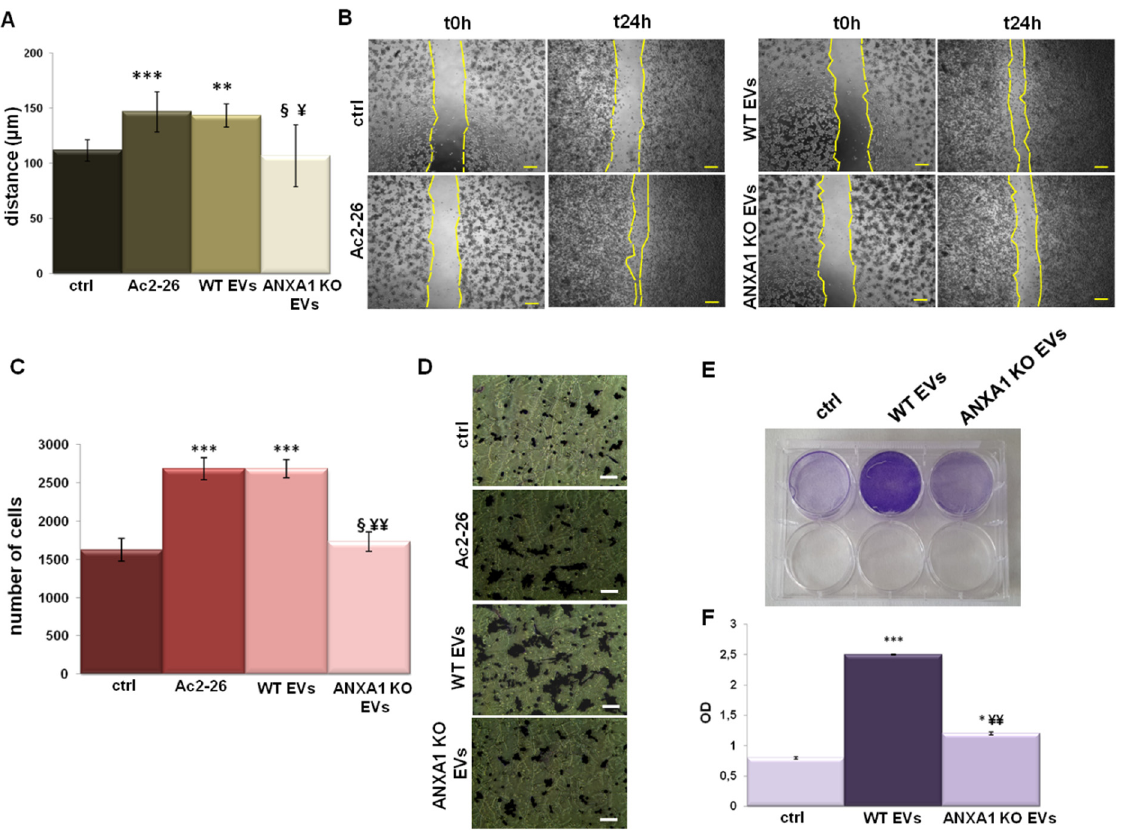
Figure 2. EVs effects on THP-1 macrophages. Analysis of ( A ) migration and ( C ) invasion speed of THP-1 macrophages treated with EVs from WT and ANXA1 KO MIA PaCa-2 cells with relative bright field images in ( B , D ), for migration and invasion, respectively. Bar = 50 µm. ( E ) Representative images of the clonogenic assay performed on THP1-macrophages in presence of WT and ANXA1 KO EVs for 24 h. ( F ) Histogram referring to the optical density (OD) obtained from 1% SDS cell dissolution and read to spectrophotometer. Data represent the mean of three independent experiments ± standard deviation with similar results. * p < 0.05; ** p < 0.01; and *** p < 0.001 for treated cells vs. PMA treated controls; § p < 0.05 for the point with ANXA1 KO EVs vs. Ac2-26; ¥ p < 0.05; and ¥¥ p < 0.01 for each point with ANXA1 KO EVs vs. WT EVs.